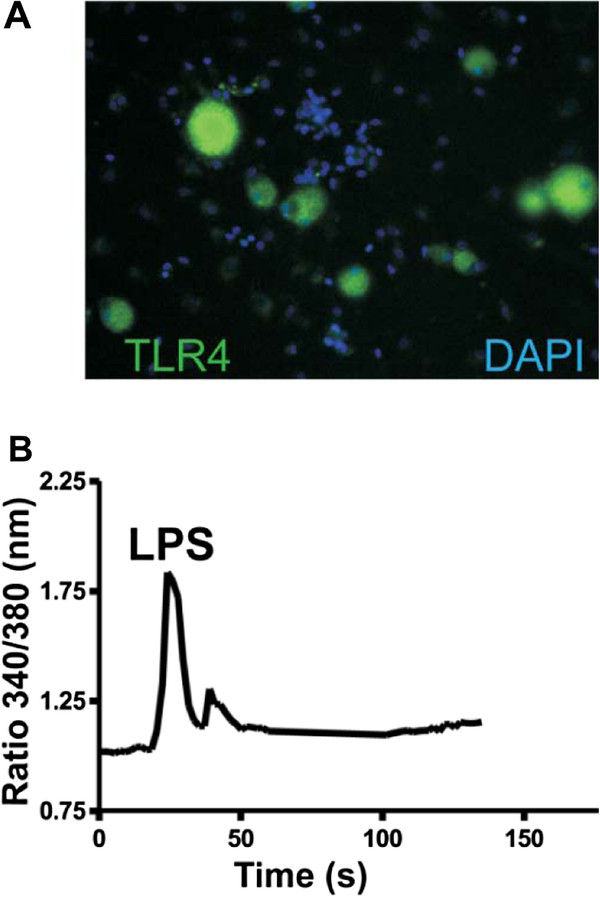
Calcium imaging of functional Toll-like receptor 4 signaling in cultured dorsal root ganglion neurons. (A) Toll-like receptor 4 (TLR4)-IR (green) is largely restricted to neurons and not non-neuronal cell types (blue, DAPI) in dissociated dorsal root ganglion (DRG) cultures. (B) Representative recording of a transient intracellular calcium increase in a dissociated DRG sensory neuron via lipopolysaccharide (LPS) administration (1 μg/mL).